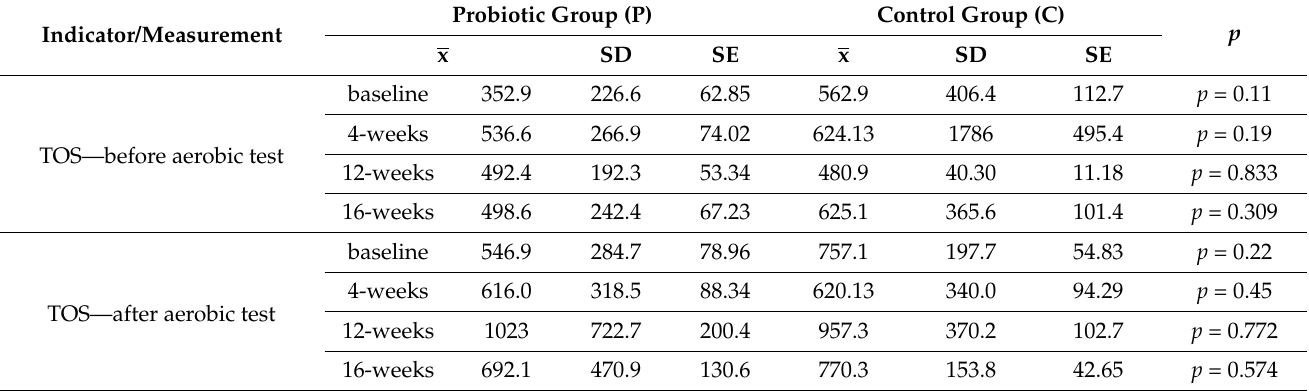
Table 13. Total oxidative status (TOS) of the blood plasma pre- and post-aerobic test and pre- and post- anaerobic test at follow-up measurements during supplementation